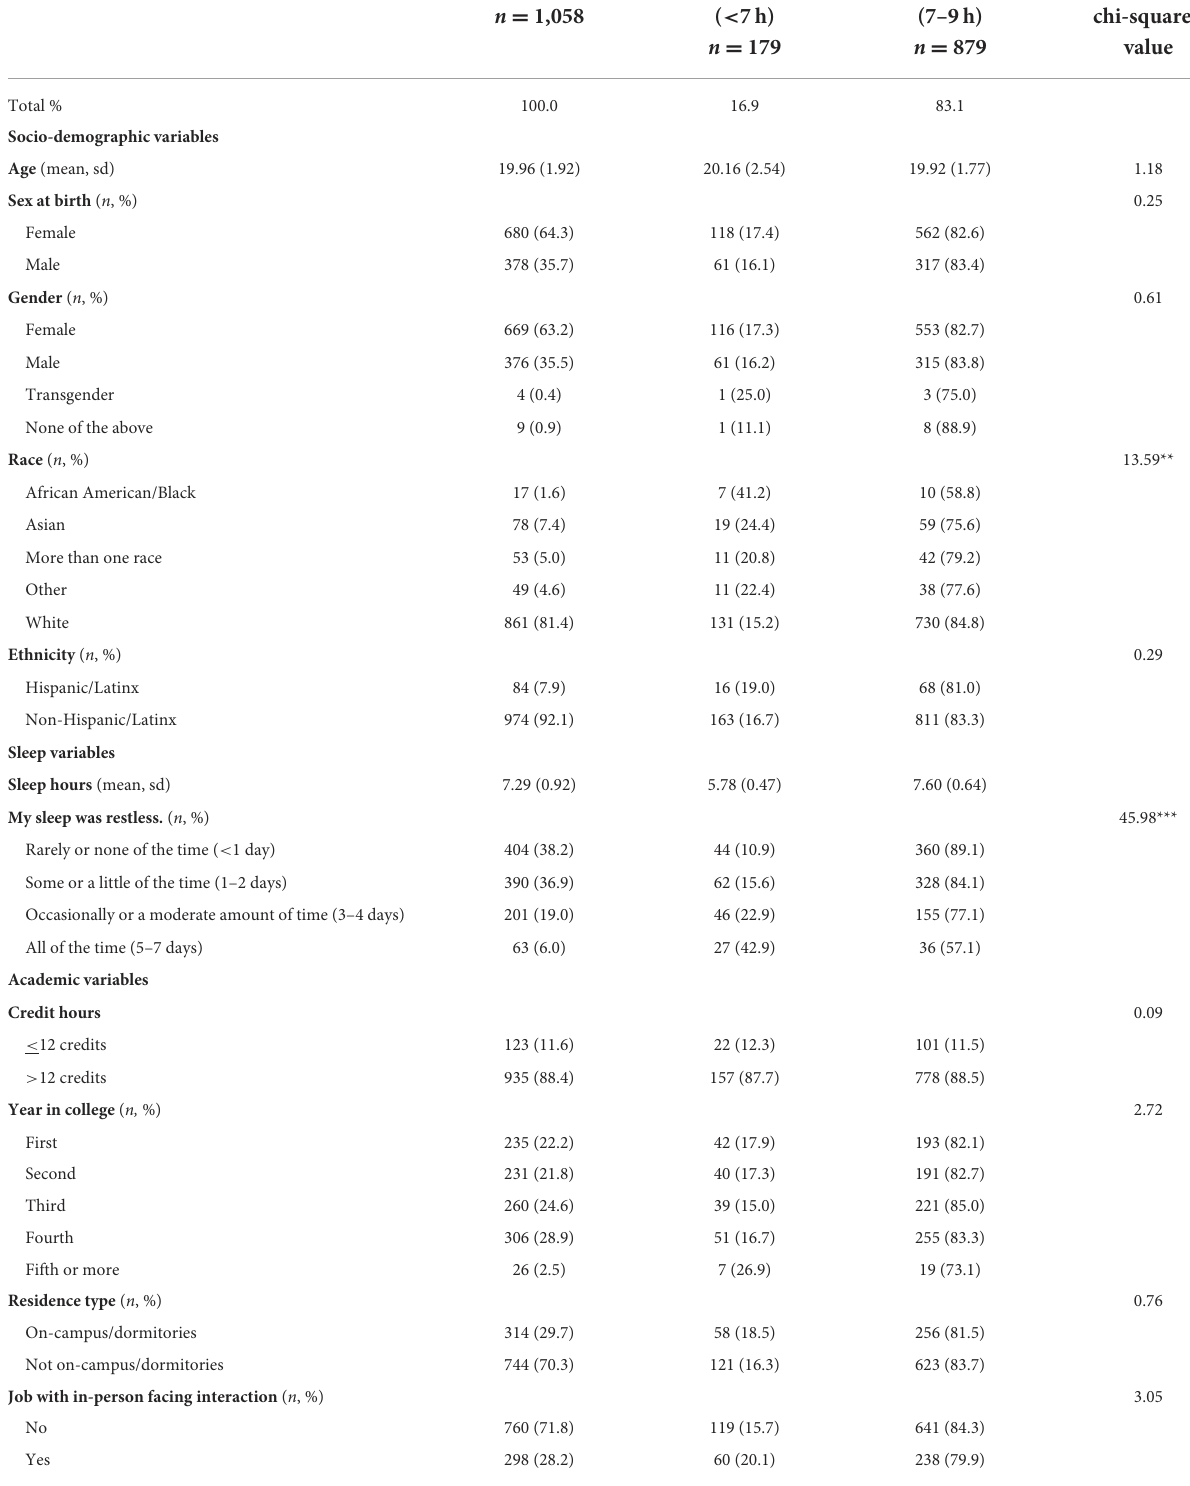
TABLE 2 Characteristics of undergraduates by sleep duration.